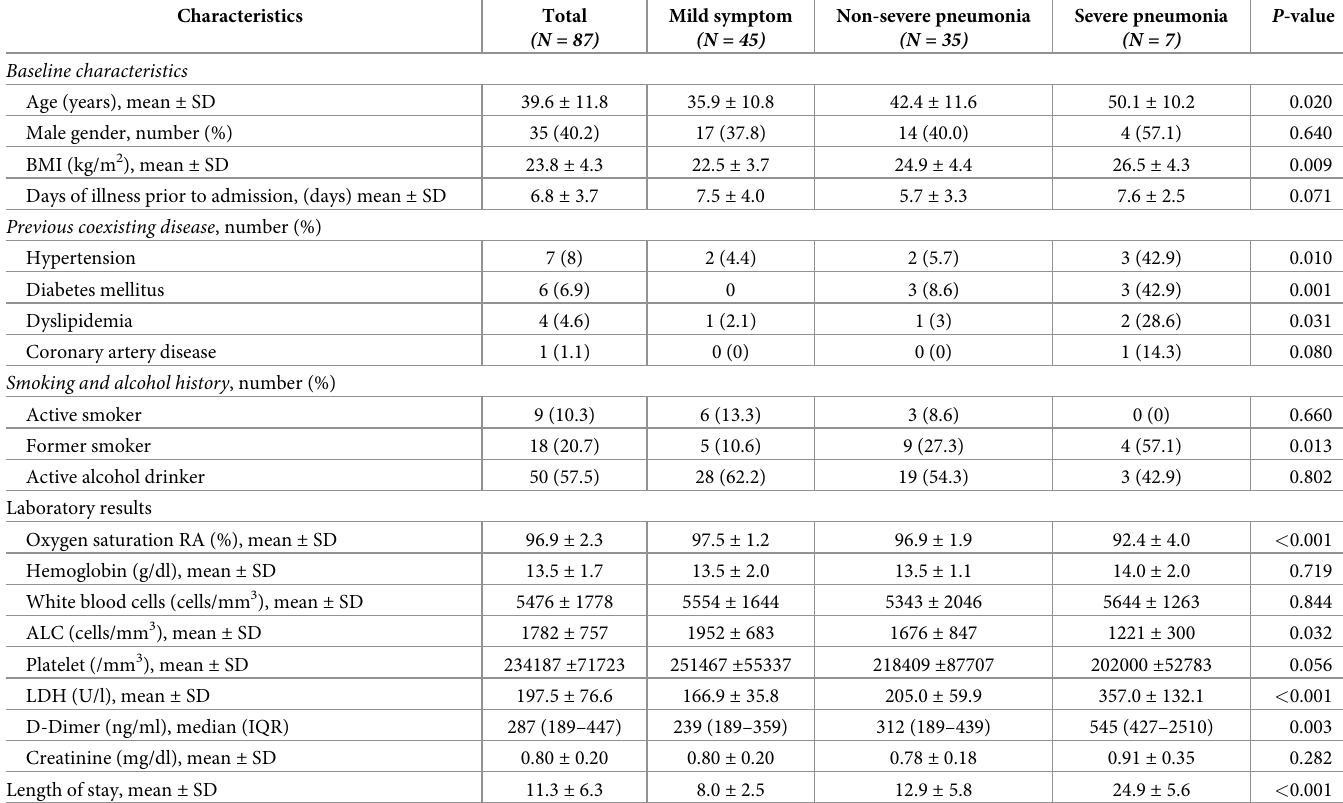
Table 1. Clinical characteristics and laboratory results of 87 recovered COVID-19 patients.